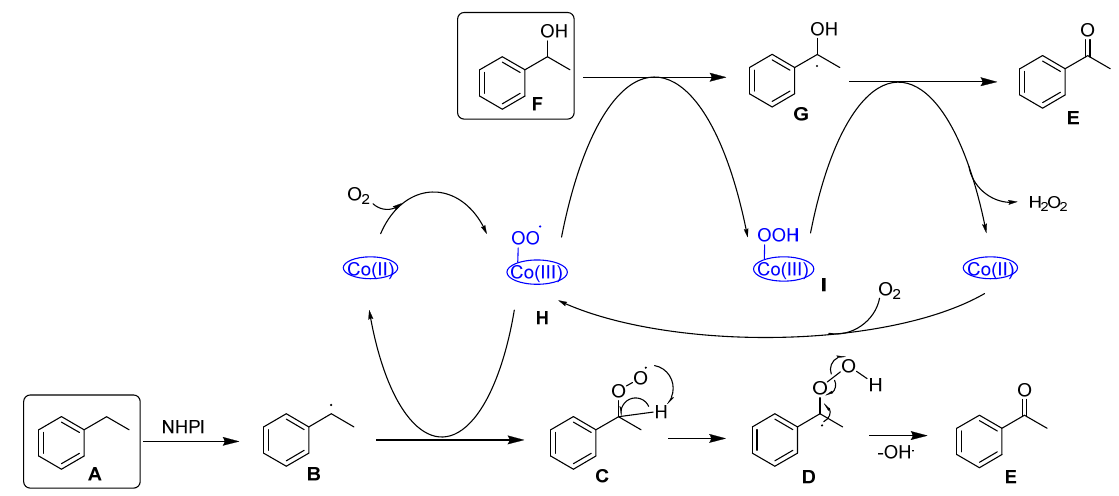
Figure 24. Proposed mechanism for akyl arenes and alcohols aerobic oxidation (adapted from [73]). Shaabani group [74] evaluated the efficiency of the hybrid catalyst Fe(II)Pc(NO 2 ) 3 S@GO (Figure 25) obtained from the iron phthalocyanine Fe(II)Pc(NO 2 ) 4 and graphene oxide (GO) nanosheets in the aerobic oxidation of a series of alcohols. In the design of this heterogeneous catalyst the authors considered the nucleophilic substitution of one of the nitro groups in Fe(II)Pc(NO 2 ) 4 by 3-(trimethoxysilyl)propane-1-thiol and then the covalent grafting of the re- sulting derivative to exfoliated graphene oxide sheets (GO) mediated by well-known hy- droxyl–methoxysilane coupling reactions.